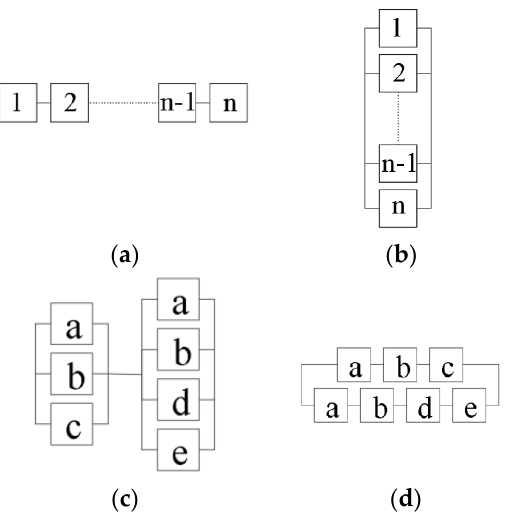
Figure 1. Scheme of basic types of systems: ( a ) series system; ( b ) parallel system; ( c ) mixed system: parallel-series; ( d ) mixed system: series-parallel.